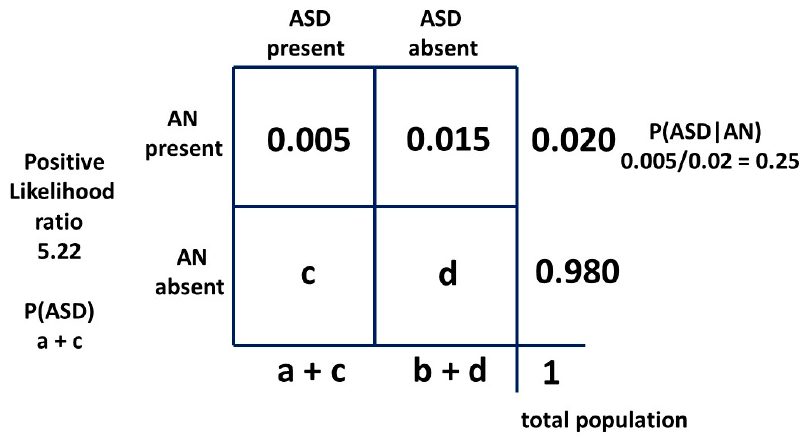
Figure A1. Bayesian 2x2 table for female model two as probabilities.